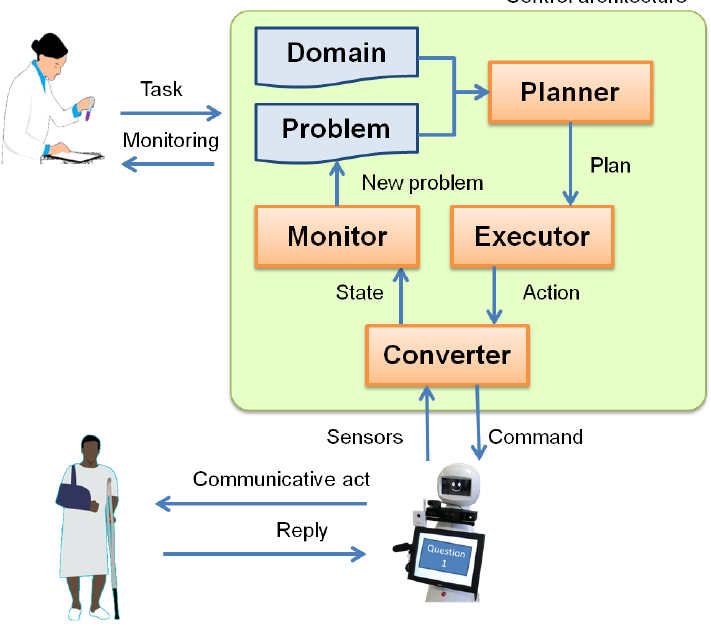
Figure 2. Conceptual schema of the use of Automated Planning for HRI in Social Assistive